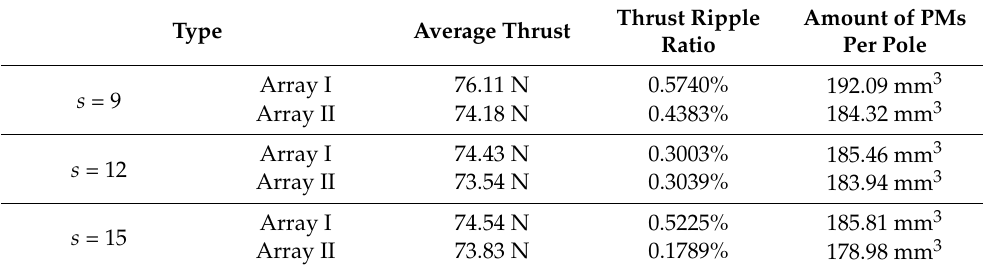
Table 6. Usage amount of PMs in the PM width-modulation arrays.